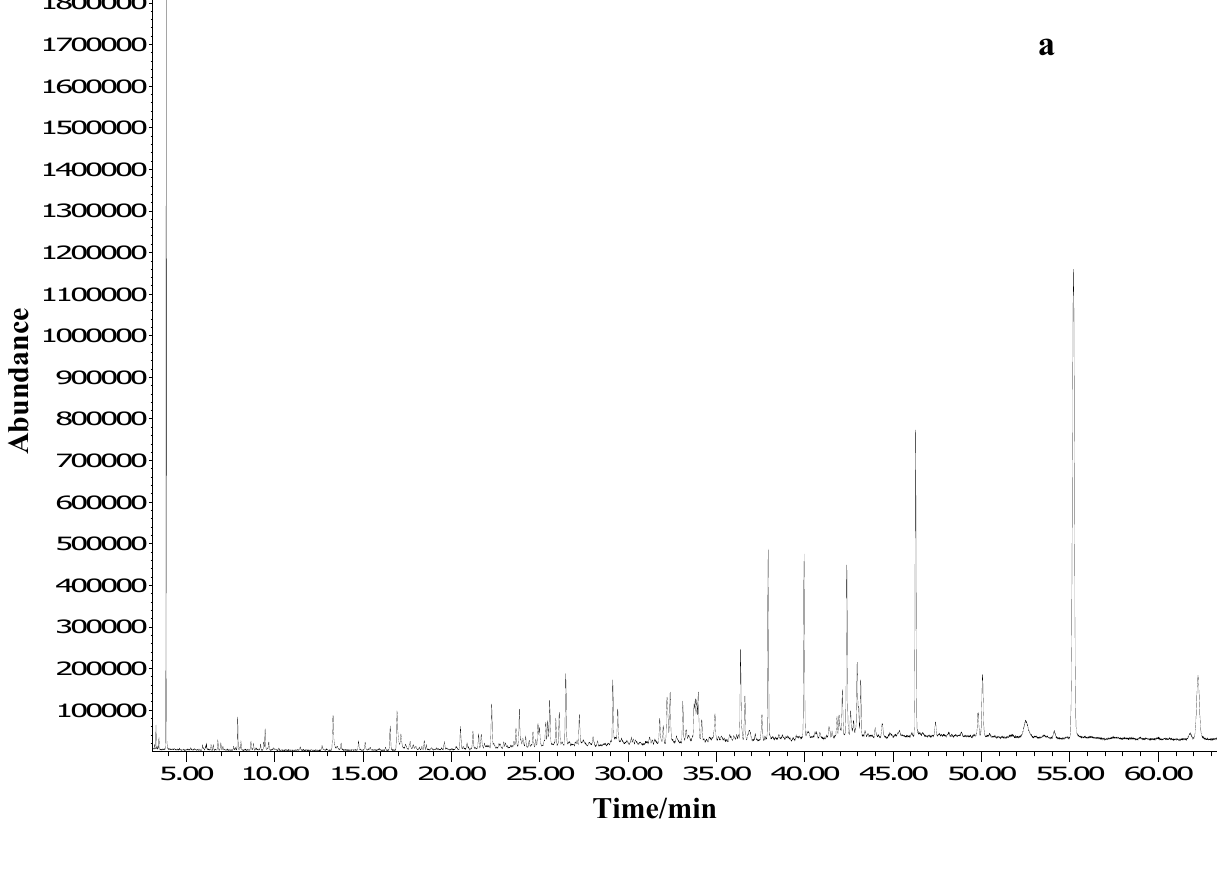
Figure 1. Representative TICs on HP-5MS column: ( a ) non-polar fraction; ( b ) polar